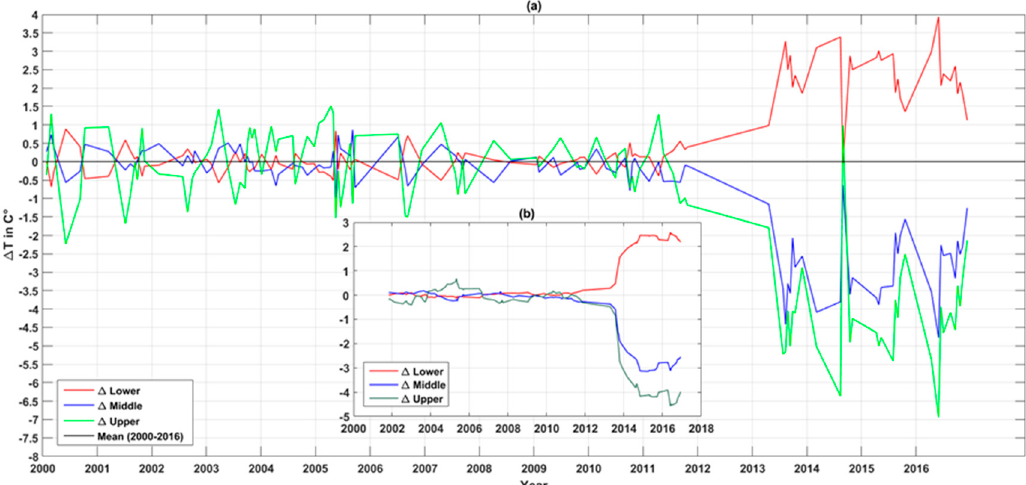
Figure 4. Relative temperature differences in the 17-year span for Bridgeton Sanitary Landfill, Missouri. ( a ) Mean LST of different regions within the landfill; ( b ) LST generated from moving average approach.